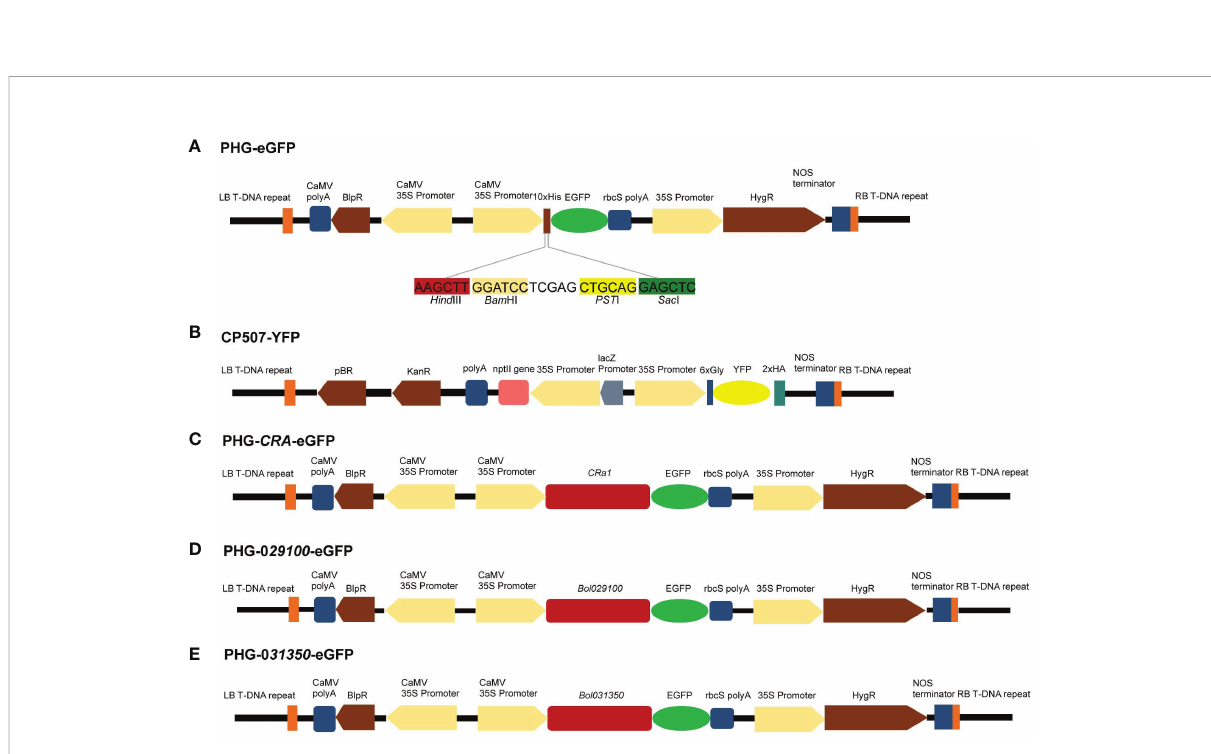
FIGURE 6 Maps of vectors with target genes. (A) Genetic map of PHG-eGFP and information of four enzymatic cut sites. (B) Genetic map of CP507-YFP. (C) Genetic map of PHG- CRa -eGFP. (D) Genetic map of PHG- 029100 -eGFP. (E) Genetic map of PHG- 031350